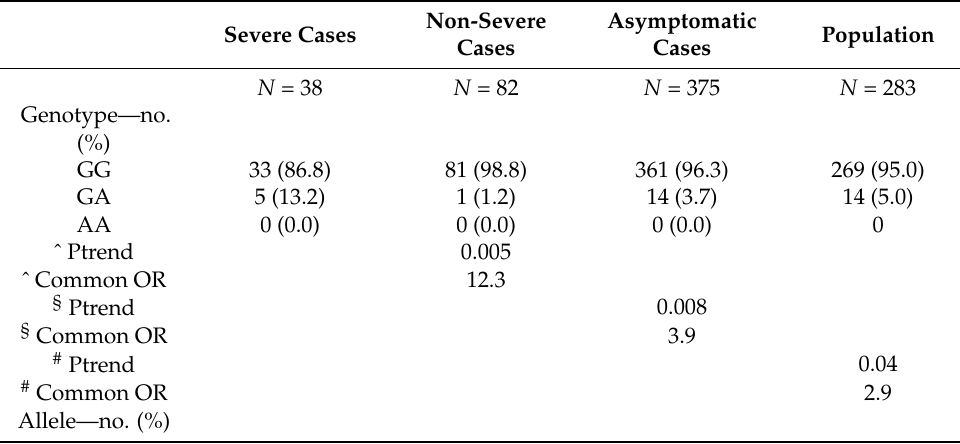
Table 4. Genetic association of rs61756766 SNV in TNFRSF13C with severe